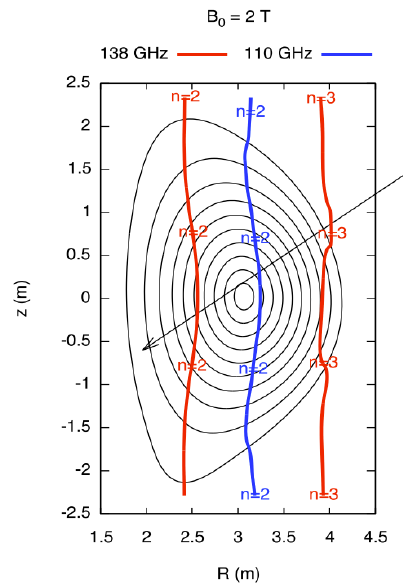
Fig. 5. EC resonances for B 0 =2T (cases 2, 3).